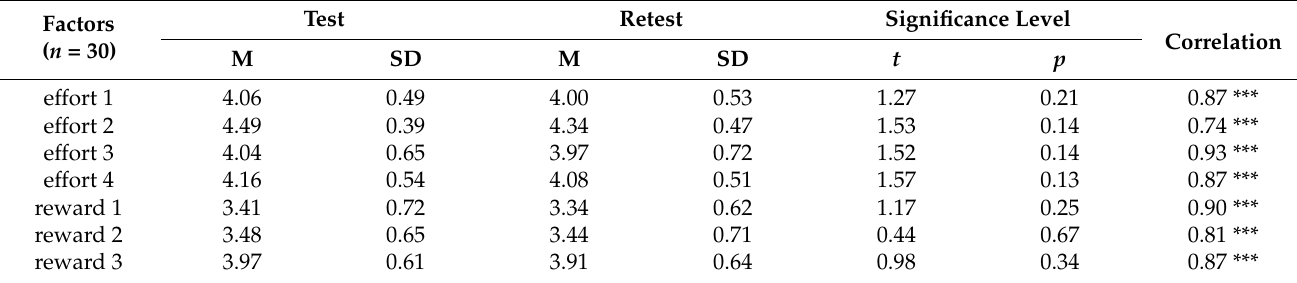
Table 7. Test-retest of effort and reward